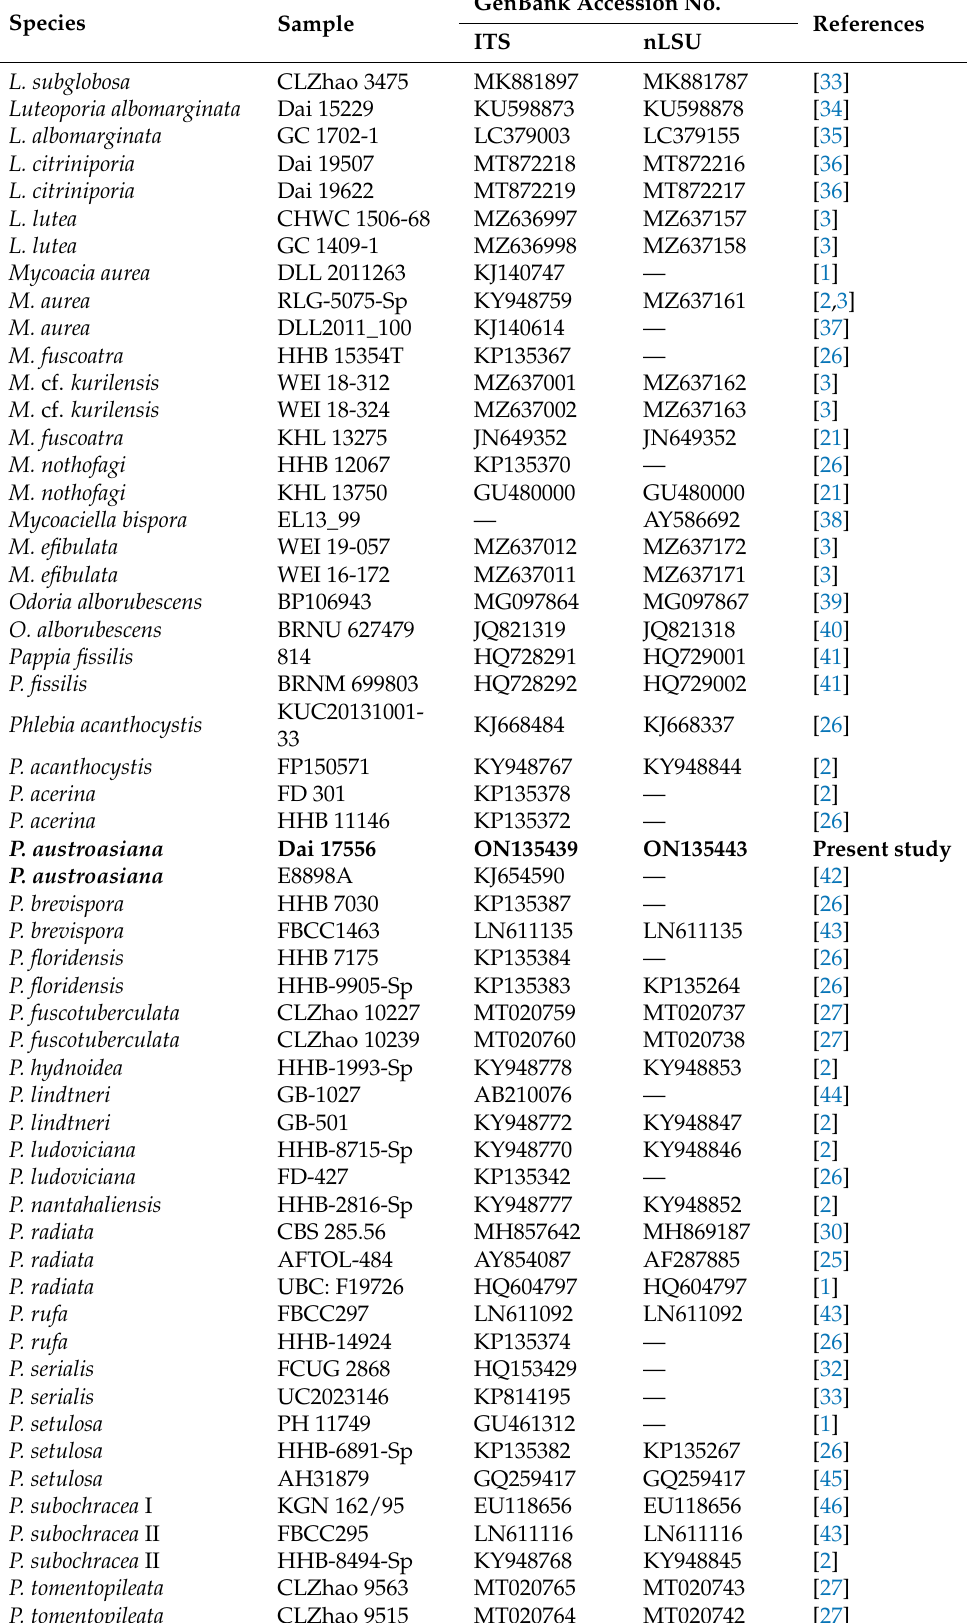
Table 1. Cont. Species